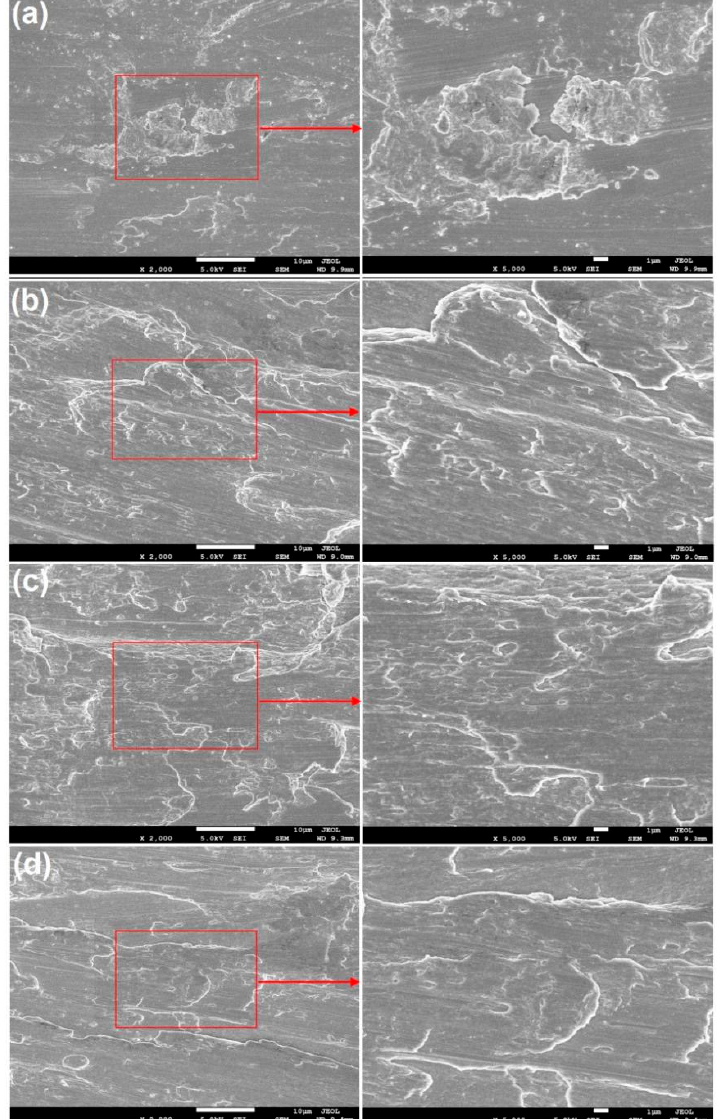
Figure 3. SEM micrograph of the surface morphology of TA1 and AA4047 after wire brushing: ( a ) TA1; ( b ) Al ① ; ( c ) Al ② ; ( d ) Al ③ .